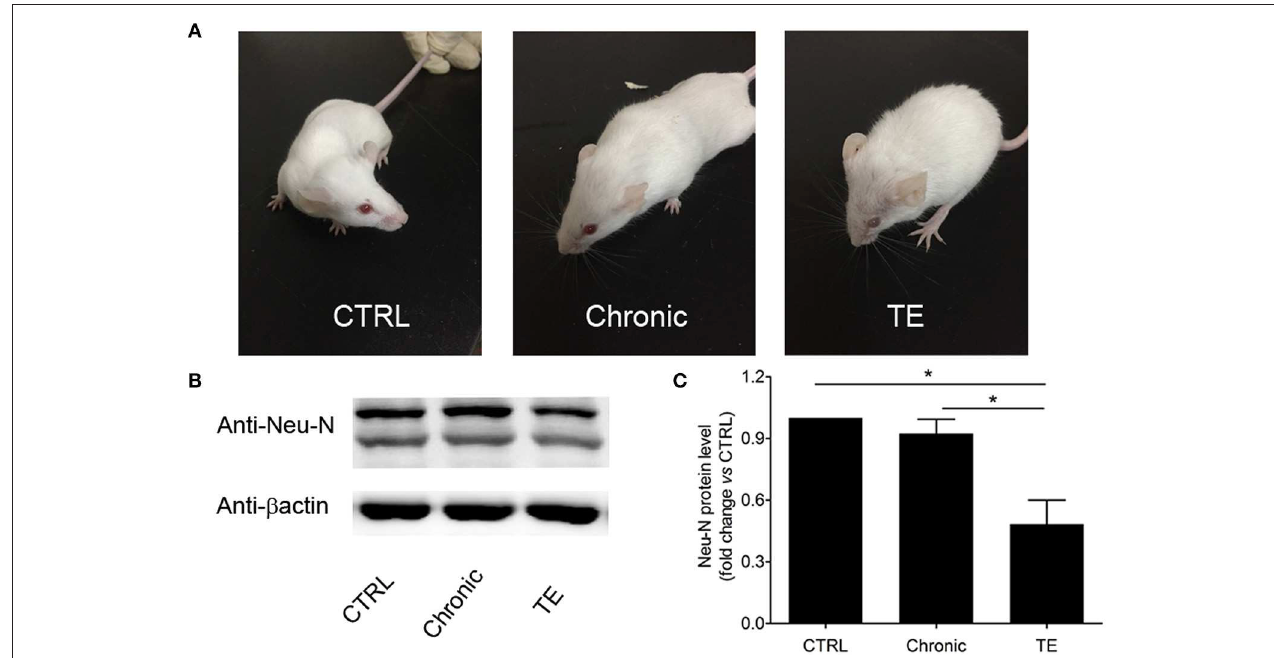
FIGURE 1 | Establishment of a murine model of toxoplasmic encephalitis (TE) (A) and identification of neuron damage in the brain of mice with TE (B,C) . * P < 0.05.